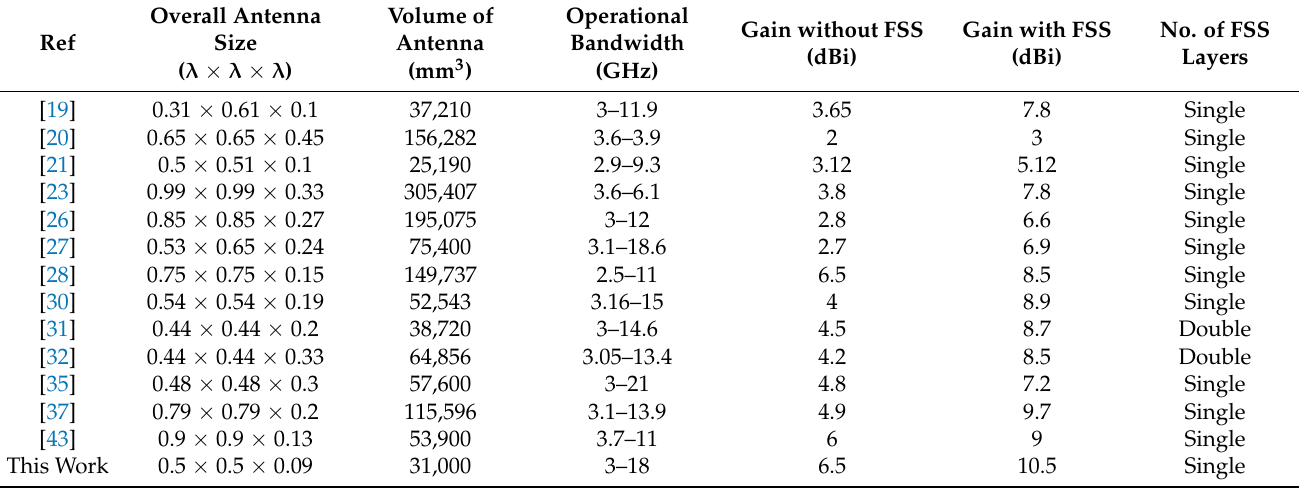
Table 1. Comparison of proposed FSS-loaded antenna with work in literature operating over same frequency bands and offering gain